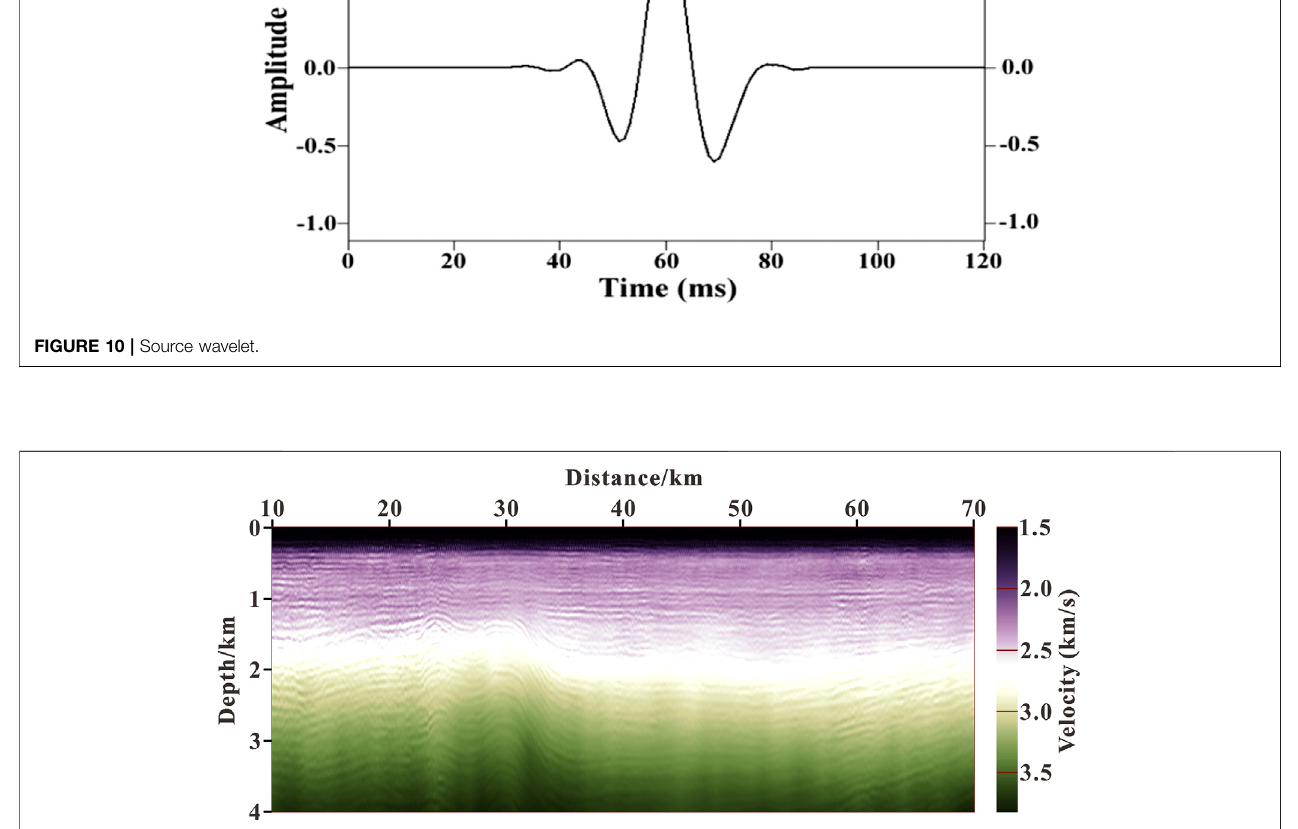
FIGURE 11 | Velocity model of fi eld